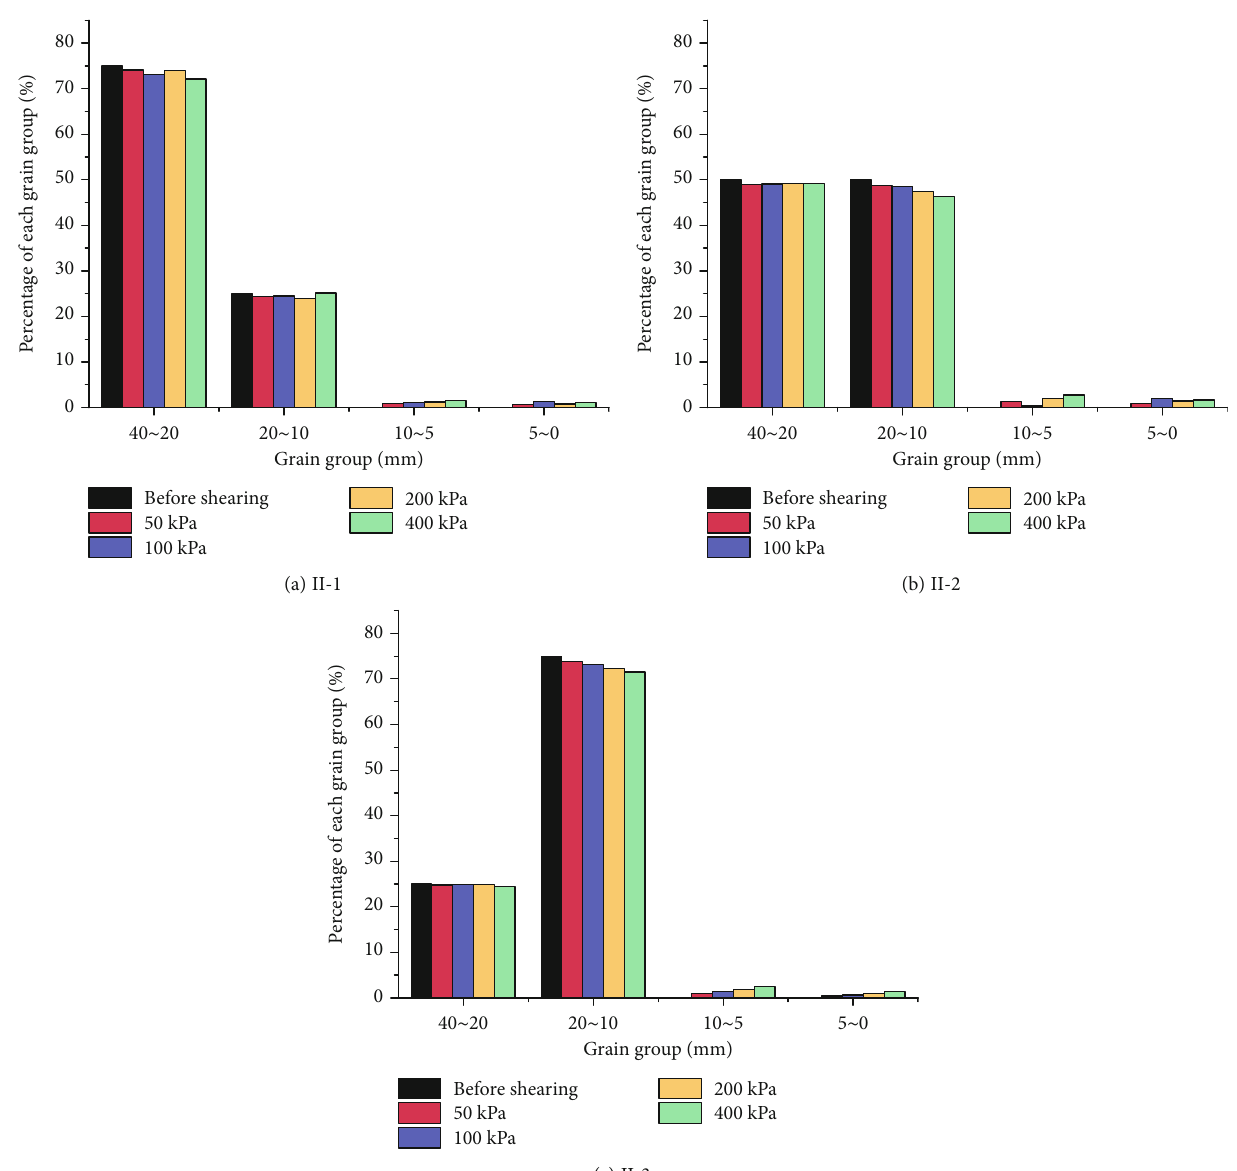
Figure 11: Histogram of contents of each grain group before and after shearing of group